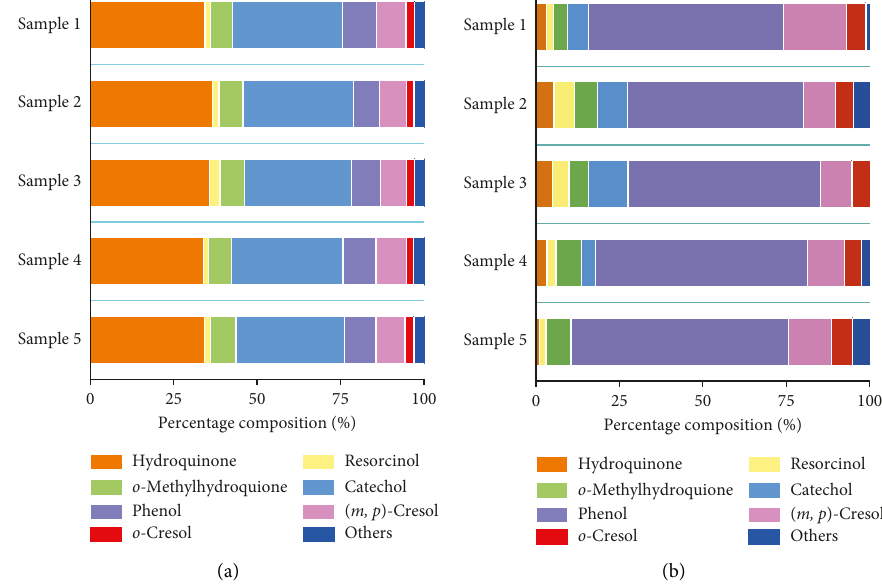
Figure 4: Percentage composition of phenolic compounds in mainstream smoke (a) and in saliva (b) of different tobacco smokers.